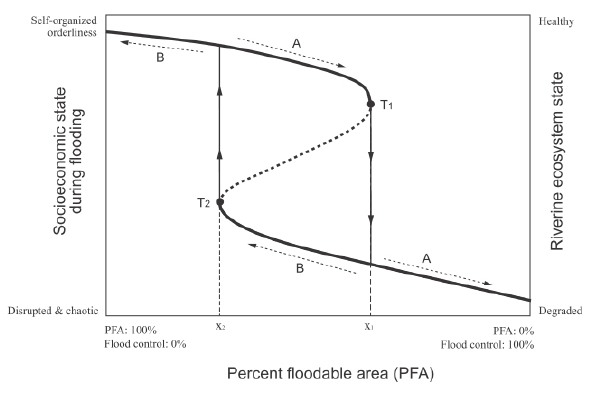
Fig. 5 . The hypothetical dynamic of percent floodable area (PFA). During the process of floodplain urbanization (trajectory A), the city increasingly relies on flood control for flood safety, moving along the upper solid line and shifting dramatically at the threshold T1 (PFA = X1) to the lower solid line. Passing T1, the floodplain has lost the natural functions to handle floodwater, and the city enters the regime where the river is degraded and the socioeconomic dynamics become disrupted and chaotic once a flood occurs. The city could move back to the regime where the river is healthy, and the city can self-organize to remain orderly during flooding by building resilience through increasing percent floodable area and decreasing the reliance on flood control. It is possible to significantly increase percent floodable area by making large and small open spaces multifunctional to convey and store floodwater during wet seasons, and by retrofitting existing buildings to be elevated, floatable, or wet-proofed. During the resilience- building process (trajectory B), the city moves along the lower solid line, but reaching X1 is not sufficient to restore the same degree of resilience before the shift (T1). The city needs to go further, passing T2 (PFA > X2) in order to move back to the more resilient